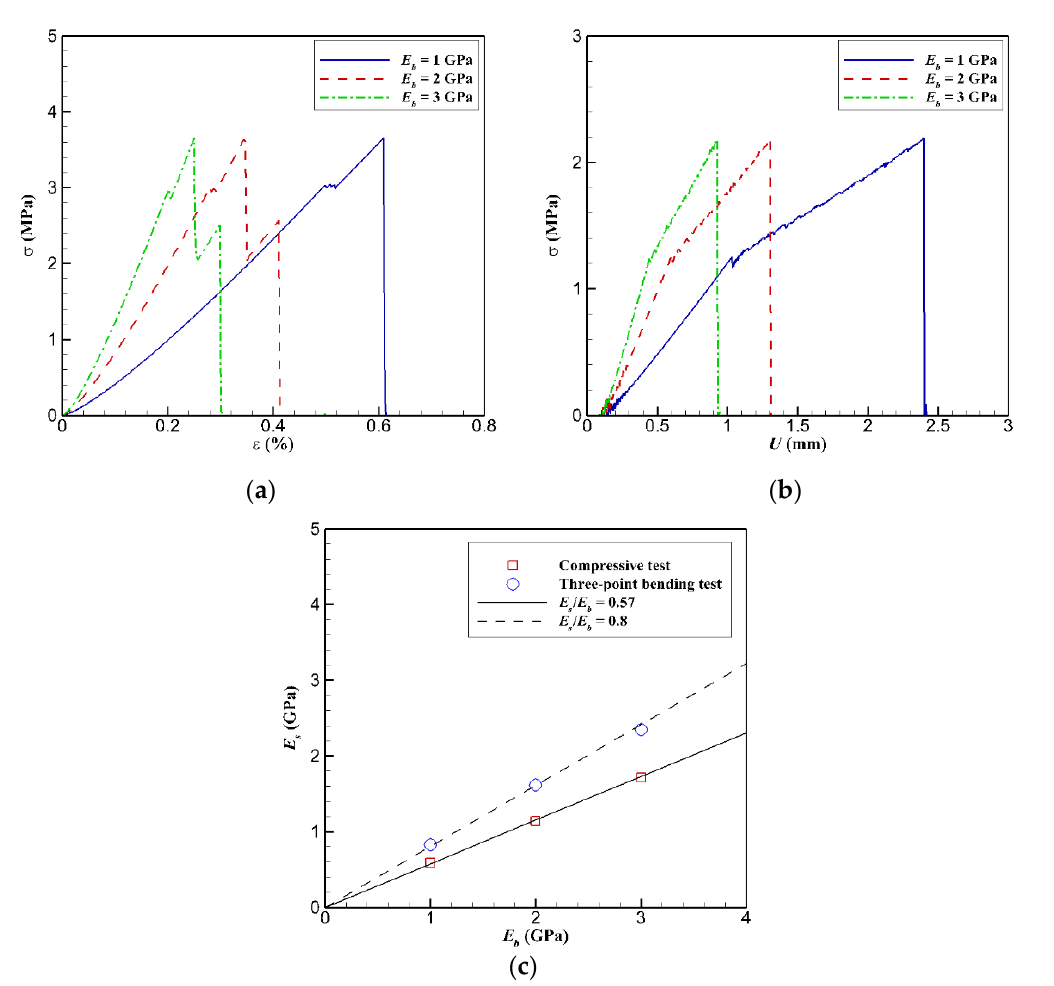
Figure 9. Effect of bond Young’s modulus: ( a ) stress–strain curve; ( b ) stress–deflection curve; ( c ) ratio of simulated Young’s modulus to bond Young’s modulus.